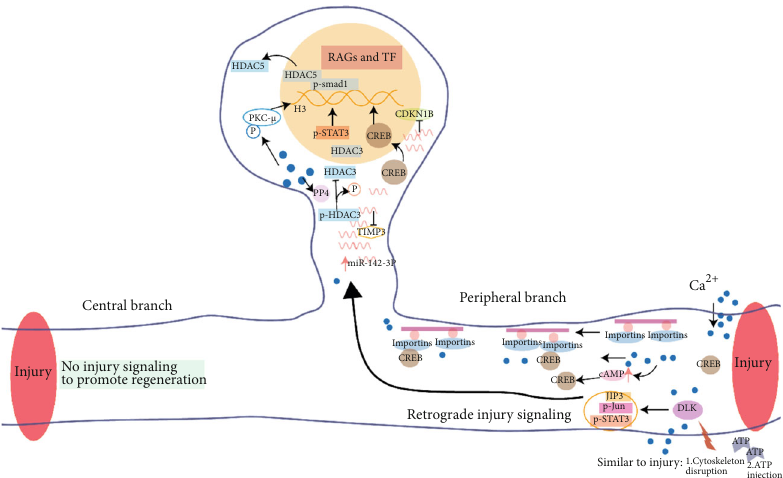
Figure 2: Signal transduction of peripheral nerve preconditioning injury regulates the RAG expression. Retrograded injury signaling after sciatic nerve injury includes calcium wave, a sensor of axon injury DLK, and axoplasmic importins. The injury signaling elicit genetic program to express RAGs and TFs responsible for enhancing axon growth. RAGs: regeneration-associated genes; TFs: transcription factors; CDKN1B: cyclin-dependent kinase inhibitor 1B; TIMP3: tissue inhibitor of metalloproteinase